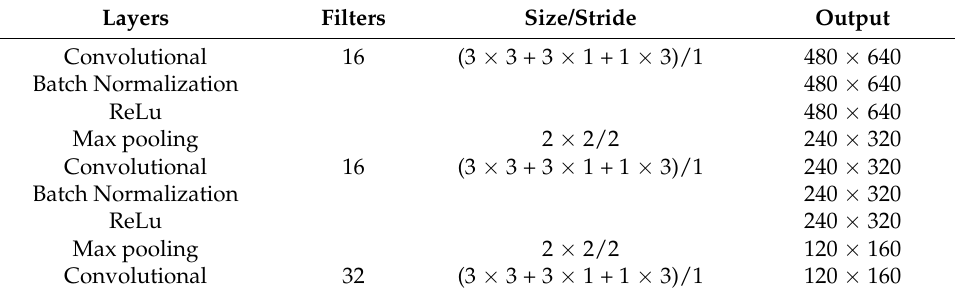
Figure 11. NBI polyp detection. Table 3. Colorectal polyp detection model architecture. Table 4. Colorectal polyp classification model